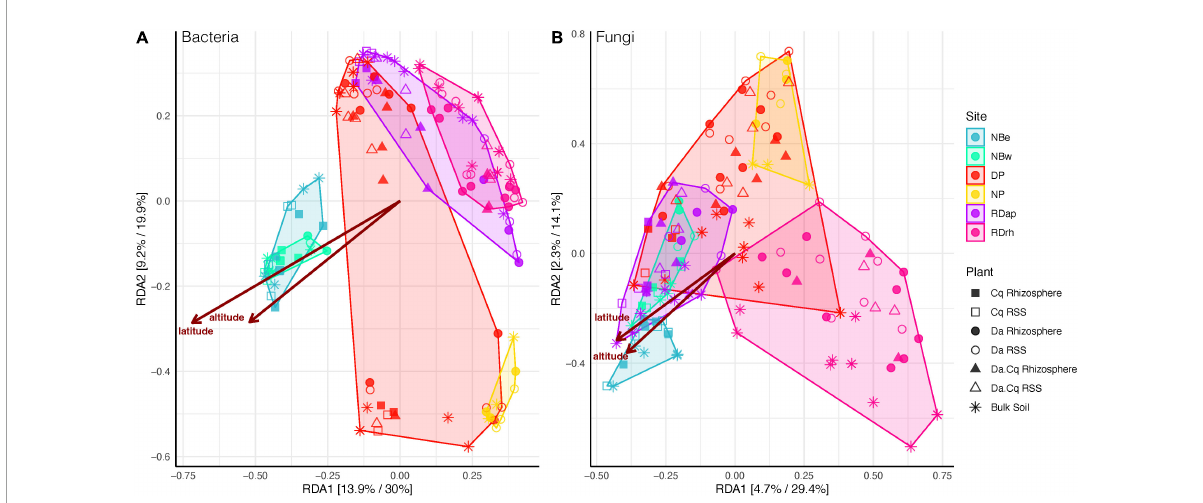
FIGURE4 Bacteria (A) and fungi (B) beta diversity for Deschampsia antarctica [Da], Colobanthus quitensis [Cq], and their association [DaCq]. A redundancy analysis of Hellinger-transformed weighted UniFrac distance was statistically chosen to describe microbial community structure in a supervised approach. Each axis shows the percentage of variance explained in an unsupervised and supervised